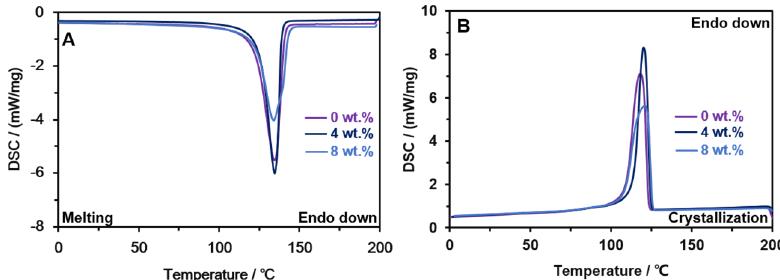
Figure 4. DSC results of the HDPE composites with a rate of 10 ℃ /min: ( A ) melting curves and ( B ) cooling (crystallization) curves.